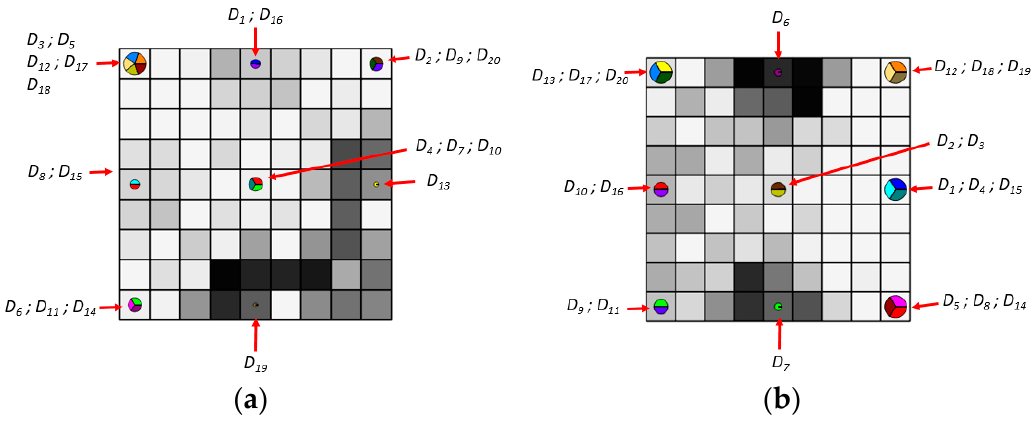
Figure 6. 9 × 9 self-organizing maps: ( a ) third question ( Q 3 ); ( b ) fourth question ( Q 4